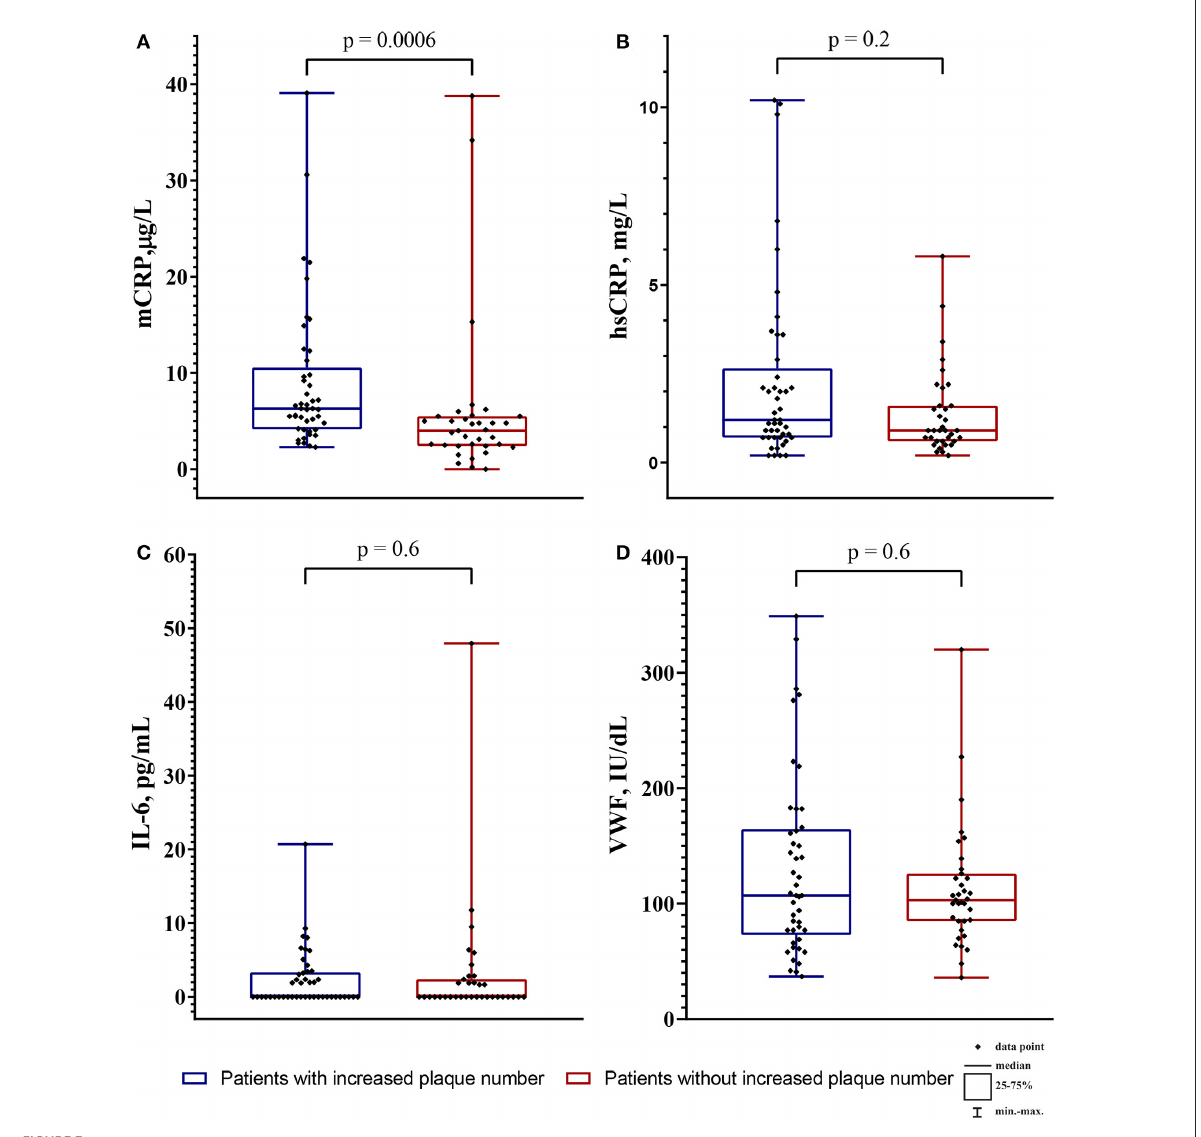
FIGURE3 The level of biomarkers in the patients with increased plaque number (blue boxplots) and the patients without increased plaque number (red boxplots). (A) the monomeric C-reactive protein (mCRP) level in µ g/L; (B) the high-sensitivity C-reactive protein (hsCRP) level in mg/L; (C) the interleukin-6 level (IL-6) in pg/mL; (D) the von Willebrand factor (VWF) level in IU/dL. The intergroup difference was analyzed by Mann-Whitney U